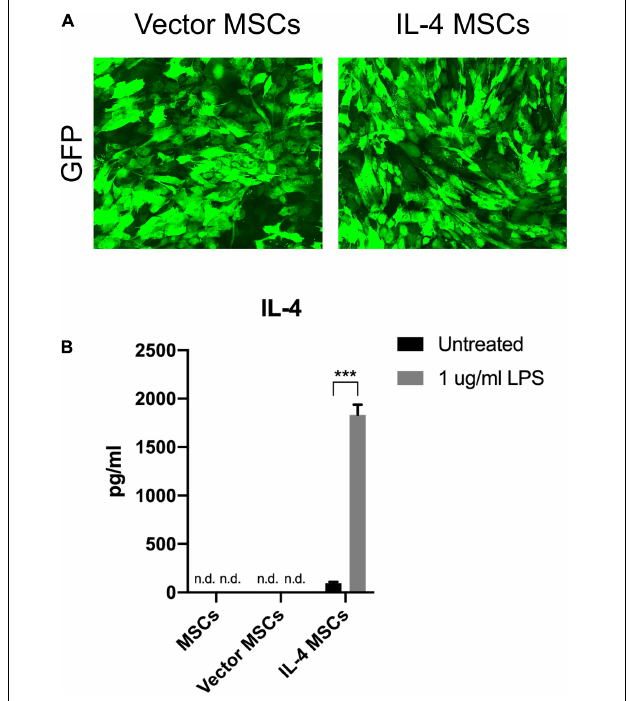
FIGURE 3 | Characterization of MSCs and genetically modified MSCs. (A) Representative fluorescence microscopy images of genetically modified MSCs. (B) IL-4 secreting levels detected by ELISA in the culture media with or without 1 µ g/ml LPS treatment for 24 h (n.d.: cannot be detected by ELISA; ***: p < 0 . 001). Note the high levels of IL-4 protein produced by the IL-4 MSCs exposed to